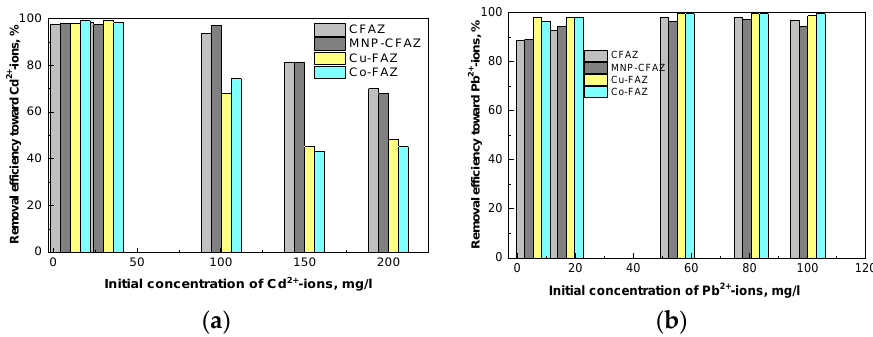
Figure 6. Removal efficiency of nonmodified and modified coal fly ash zeolites toward ( a ) Cd 2+ -ions; Figure 6. Removal e ffi ciency of nonmodified and modified coal fly ash zeolites toward ( a ) Cd 2 + -ions; ( b ) Pb 2+ -ions. ( b ) Pb 2 +